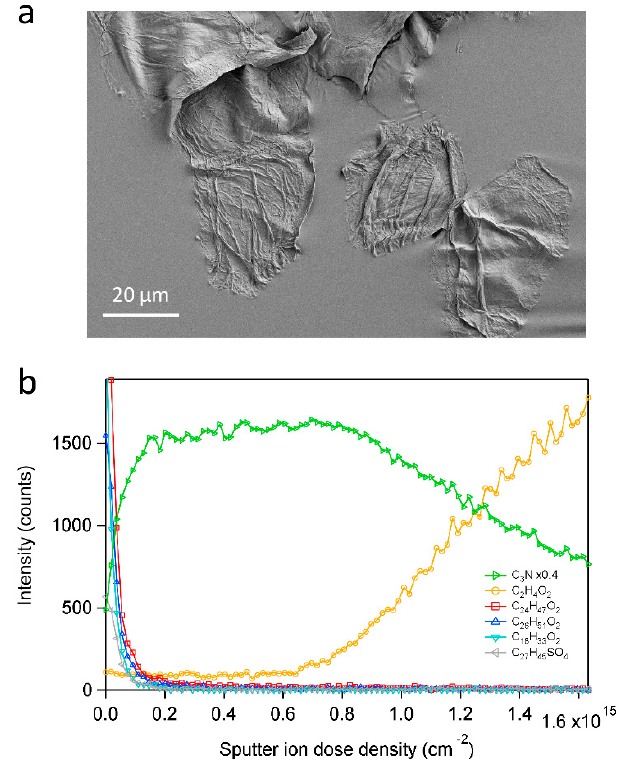
Figure 2. 3D ToF-SIMS analysis of single corneocyte layer. ( a ) SEM image and ( b ) negative ion depth profiles of single corneocyte layers deposited on tape substrate by tape stripping. The monitored ions represent proteins (C 3 N − ), tape (C 2 H 4 O 2 − ), C24:0 and C26:0 fatty acids (C 24 H 47 O 2 − and C 26 H 51 O 2 − , respectively), oleic acid (C18:1, C 18 H 33 O 2 − ) and cholesterol sulfate (C 27 H 45 SO 4 − ). The imaged area in ( a ) was not analyzed by 3D ToF-SIMS.